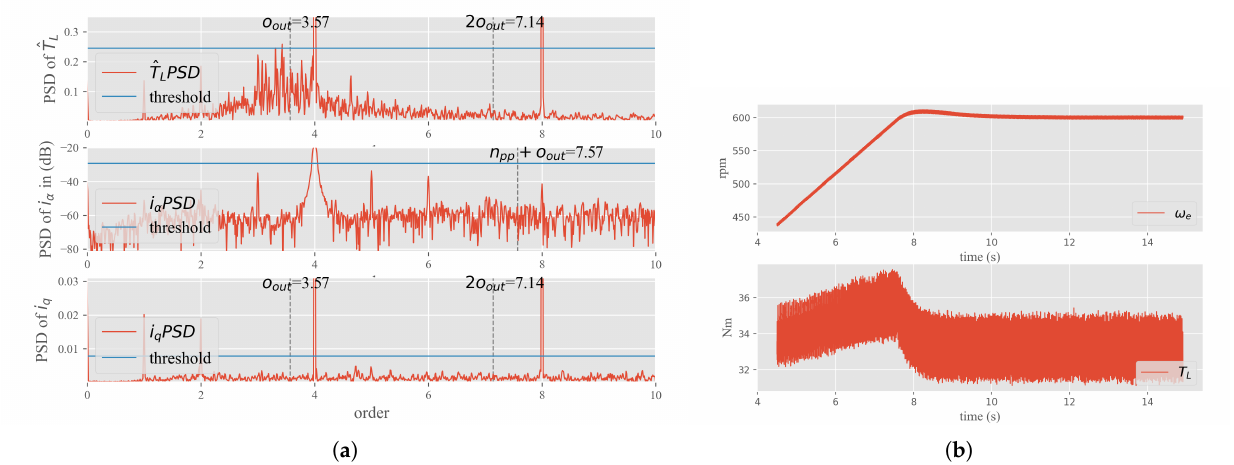
Figure 6. Speed varying experiment of the healthy motor ( a ) power spectrum density and ( b ) graphi- cal transients of speed and